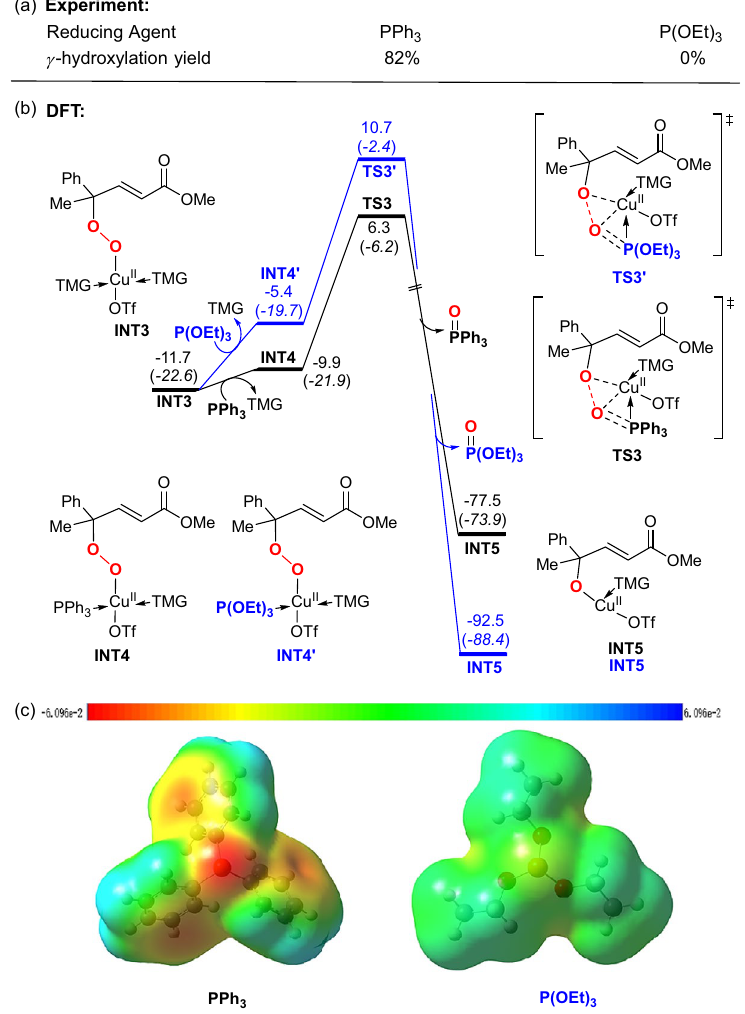
Figure 3. ( a ) The reaction yields of γ -hydroxylated productusing different reducing agents. ( b ) Theoretically calculated reduction process using different reducing agents. Relative free energies (electronic energies) are in kcal/mol. ( c ) The electrostatic potential surfaces (ESP) of PPh 3 and P(O)Et 3 mapped between − 6.096e−2 to + 6.096e−2. Red as negative extreme and blue as positive extreme. Note GaussView6, https ://gauss ian.com/ gv6ma